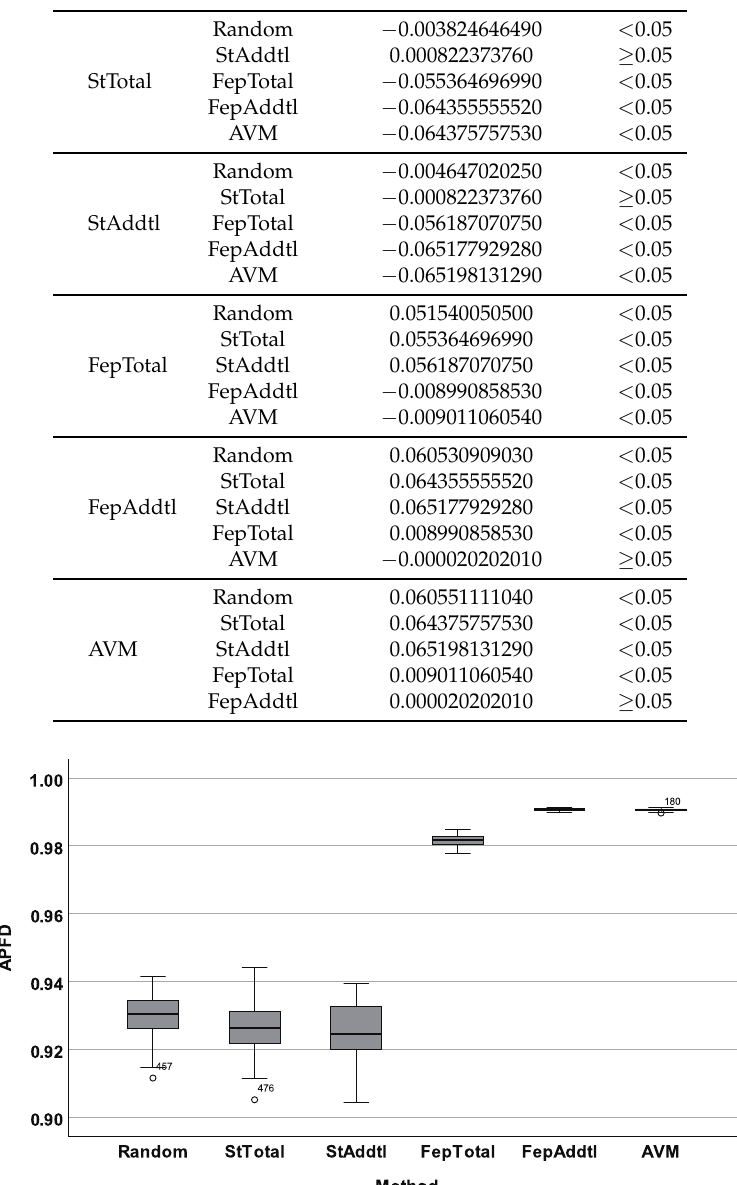
Figure 3. A comparison of test case prioritization